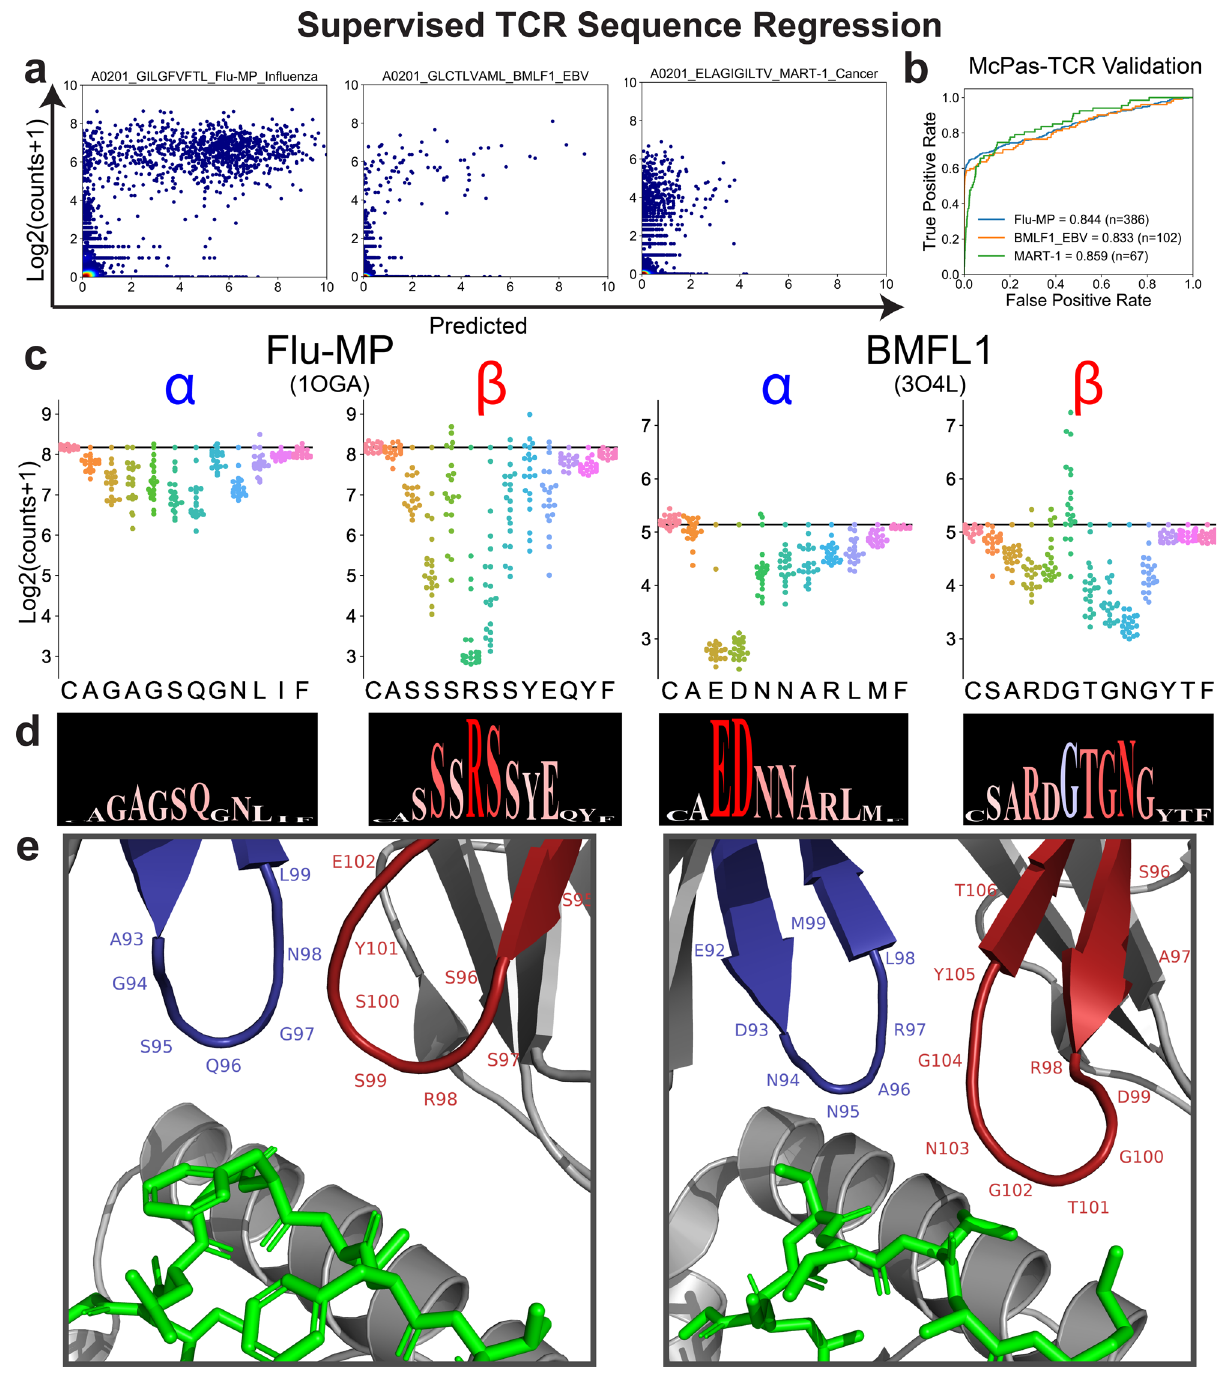
Fig. 3 Supervised TCR sequence regression. a In order to test the ability of a supervised deep learning method to learn and regress continuous value outputs, we collected published single-cell data from 10x Genomics where 57,229 unique α / β pairs were collected with a count-based measurement (as a proxy for binding af fi nity) to 44 speci fi c peptide-MHC (pMHC) multimers and 6 negative controls. A fi vefold cross-validation strategy was employed on every antigen to obtain independently predicted regression values for every α / β pair to a given antigen and predicted vs actual counts are shown for a select three antigens. b For the shown epitopes, experimentally derived antigen-speci fi c CDR3 β TCR sequences were collected from the McPAS-TCR database and models trained on the 10x Genomics dataset were applied to this independent dataset of TCRs to assess the classi fi cation performance via examining the ROC curves and their corresponding AUCs. c For the Flu-MP and BMLF1 epitopes where data from the 10x Genomics dataset were available to train our models, crystal structures and their corresponding TCR CDR3 sequences were also collected from The Protein Data Bank and permutation analysis was conducted to analyze the sensitivity of each residue to the predicted binding af fi nity from our deep learning model. The results of this model are shown for the corresponding α - and β -chain for both antigens. d To create compact representations of the information in our residue sensitivity analysis, we propose a visualization of this information termed a Residue Sensitivity Logo (RSL). e Crystal structures highlighting the relevant α (blue) and β (red) CDR3 regions. Predictive performance of Residue Sensitivity analysis to identify known contact residues shown in Supplementary Fig.